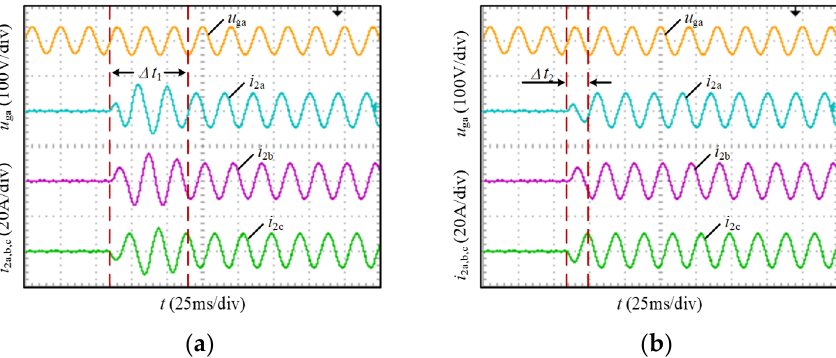
Figure 18. Experimental results of the dynamic response: ( a ) Traditional method; ( b ) proposed method.